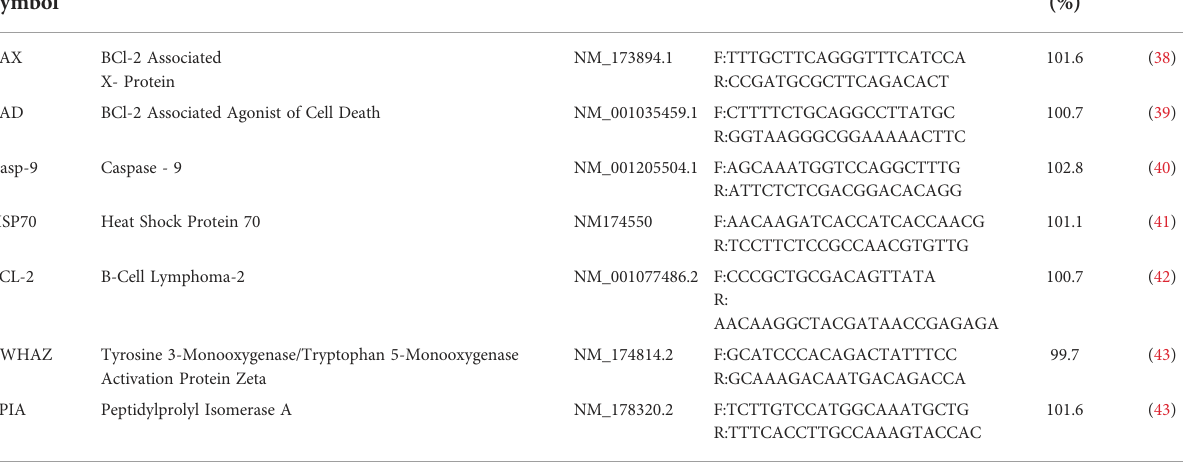
TABLE 1 Primer sequences used in